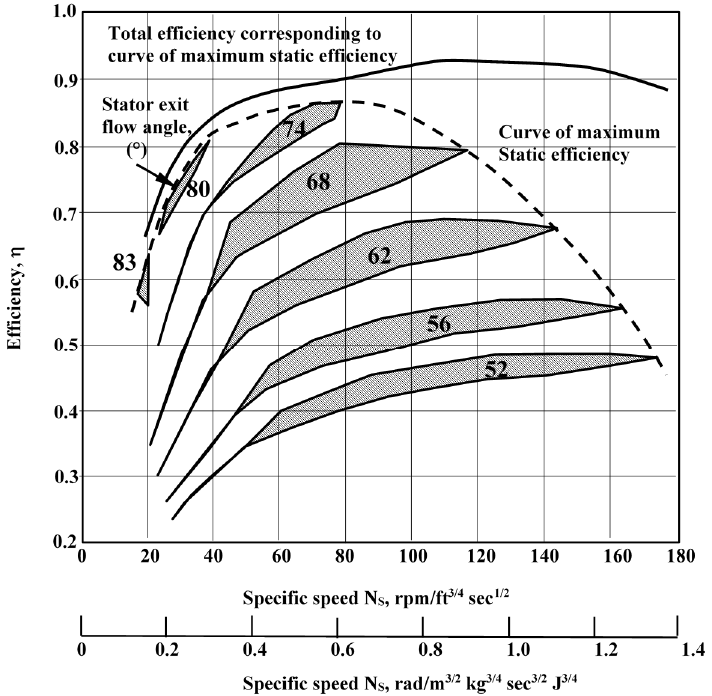
Figure 8. Relationship between Ω s and the general geometry of the rotor